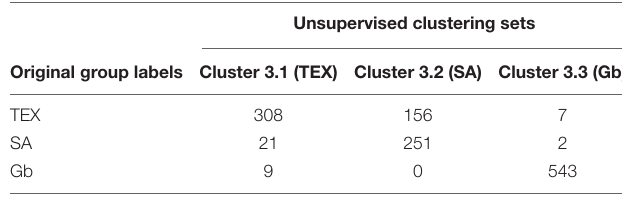
TABLE 2 | Summary of K-modes unsupervised clustering ( k = 2). TABLE 3 | Summary of K-modes unsupervised clustering ( k =